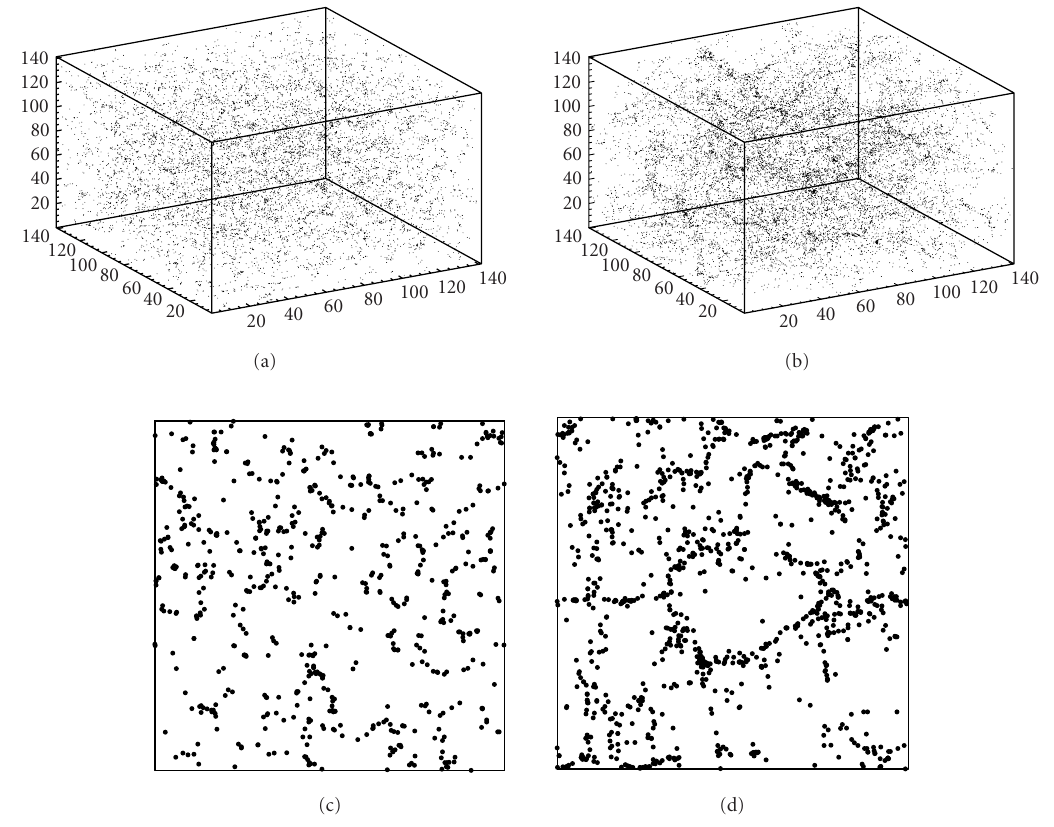
Figure 11: Simulated data sets. (a) The Voronoi vertices point pattern and (b) the galaxies of the GIF Λ -CDM N-body simulation. (c) One 10 h − 1 width slice of each data set.